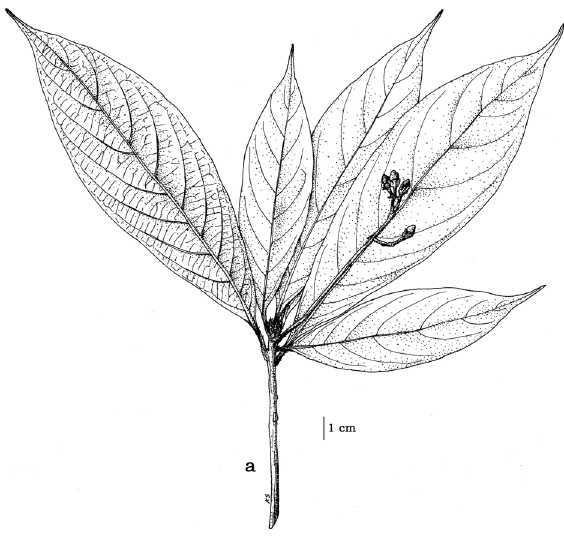
Figure 1. Phoebe lanceolata (Nees) Nees (Lauraceae). a - fruiting twig